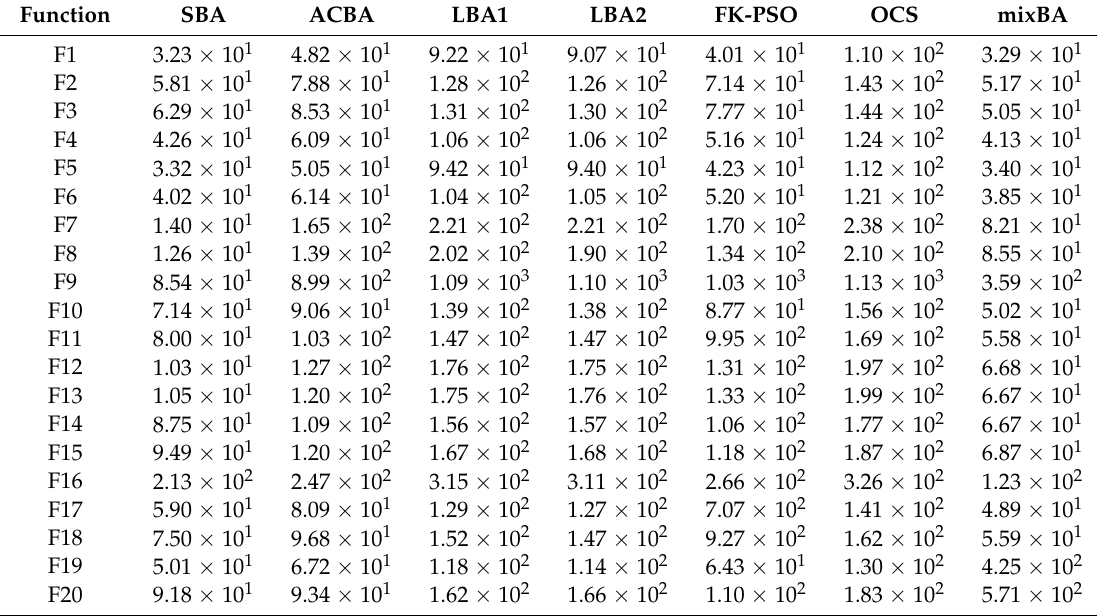
Table A2. The computation time of each